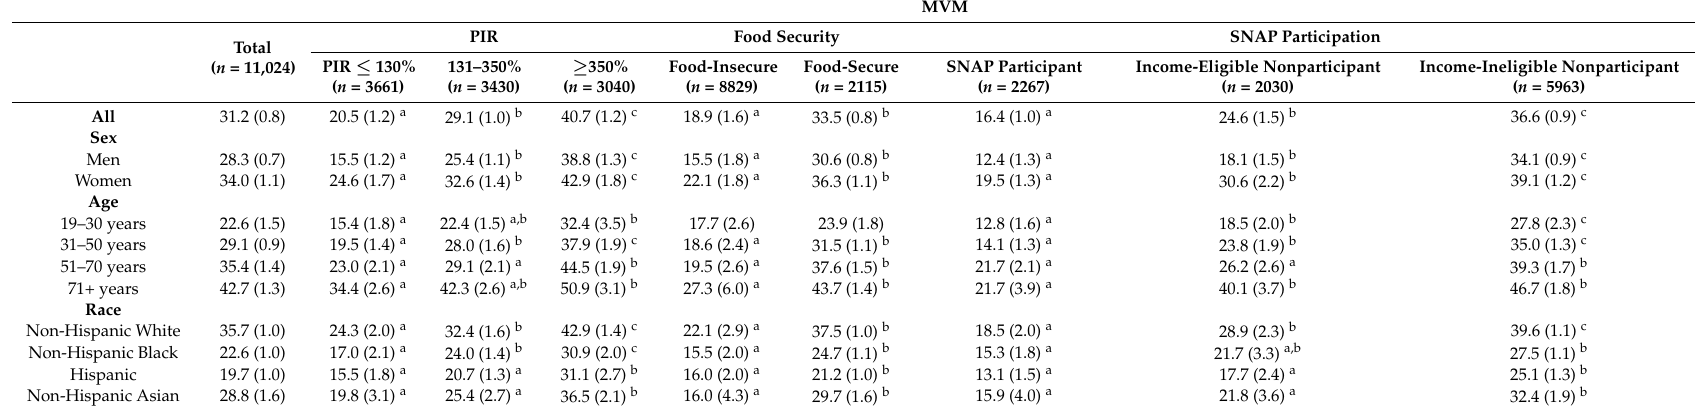
Table 3. Estimated prevalence (%) of multivitamin-mineral (MVM) use by selected poverty and demographic indicators, among U.S. adults, 2011–2014 1,2 .